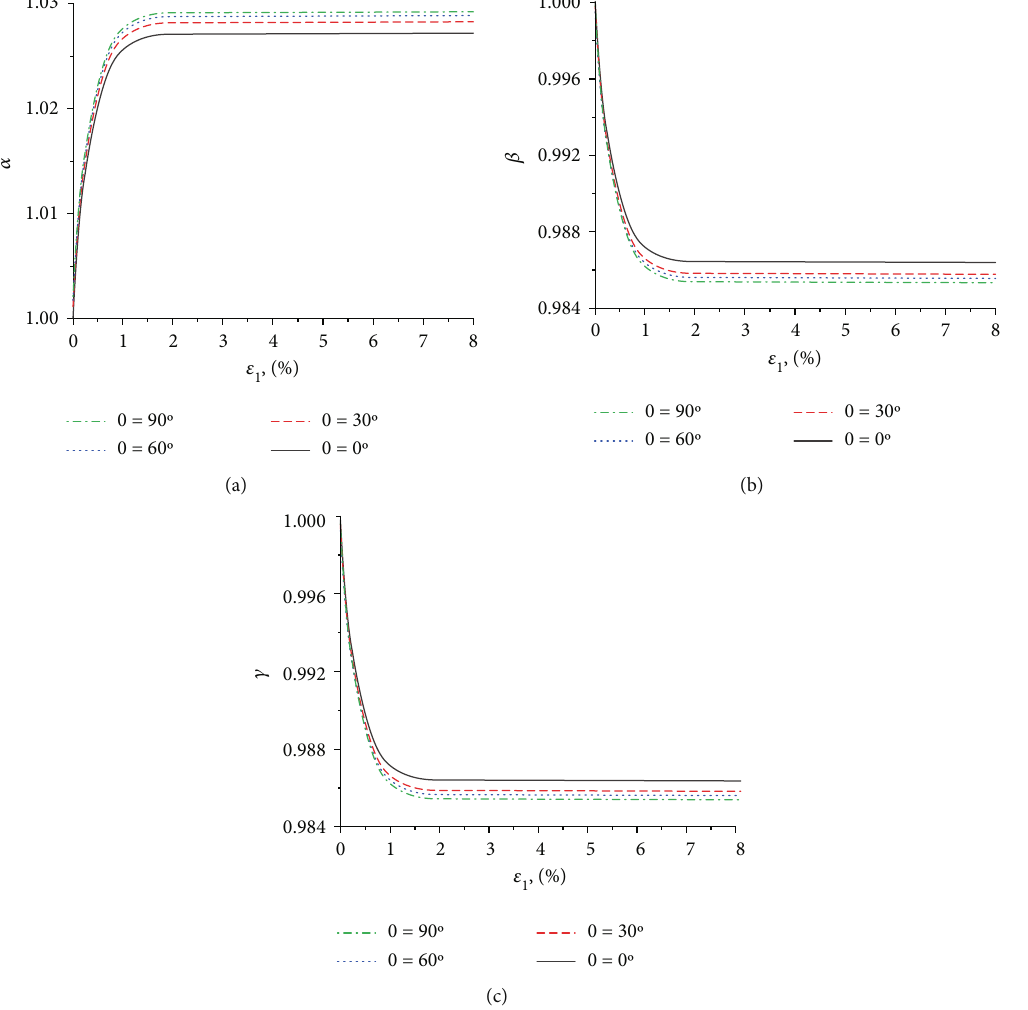
Figure 10: Changes of anisotropic parameters for various bedding angle: (a) α vs. axial strain; (b) β vs. axial strain; (c) γ vs. axial